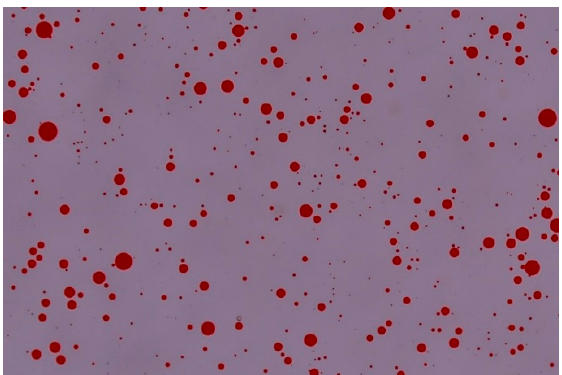
Figure 6. Droplets trapped into the silicone oil.